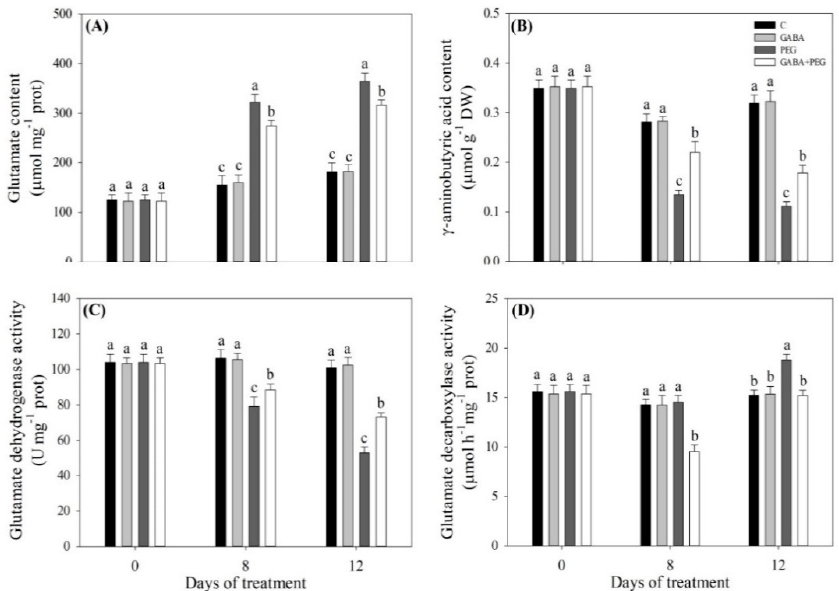
Figure 8. Effects of exogenous γ -aminobutyric acid (GABA) pretreatment on ( A ) glutamate content, ( B ) γ -aminobutyric acid content, ( C ) glutamate dehydrogenase activity, and ( D ) glutamate decarboxylase activity in the leaves of creeping bentgrass under non-stress and water stress conditions. Vertical bars indicate ± SE of mean ( n = 4). Different letters above columns indicate significant difference at a particular day based on the LSD ( P ≤ 0.05). C, well-watered control; GABA, well-watered control pretreated with GABA; PEG, PEG-induced water stress; GABA + PEG, water- stressed plants pretreated with GABA. Figure 9. Integrative pathways induced by water stress and exogenous application of γ -aminobutyric acid (GABA) in leaves of creeping bentgrass under non-stress and water stress conditions. Red indicates a significant upregulation, green indicates a significant downregulation, and white indicates no significant change. C, well-watered control; GABA, well-watered control pretreated with GABA; PEG, PEG-induced water stress; GABA + PEG, water-stressed plants pretreated with GABA.